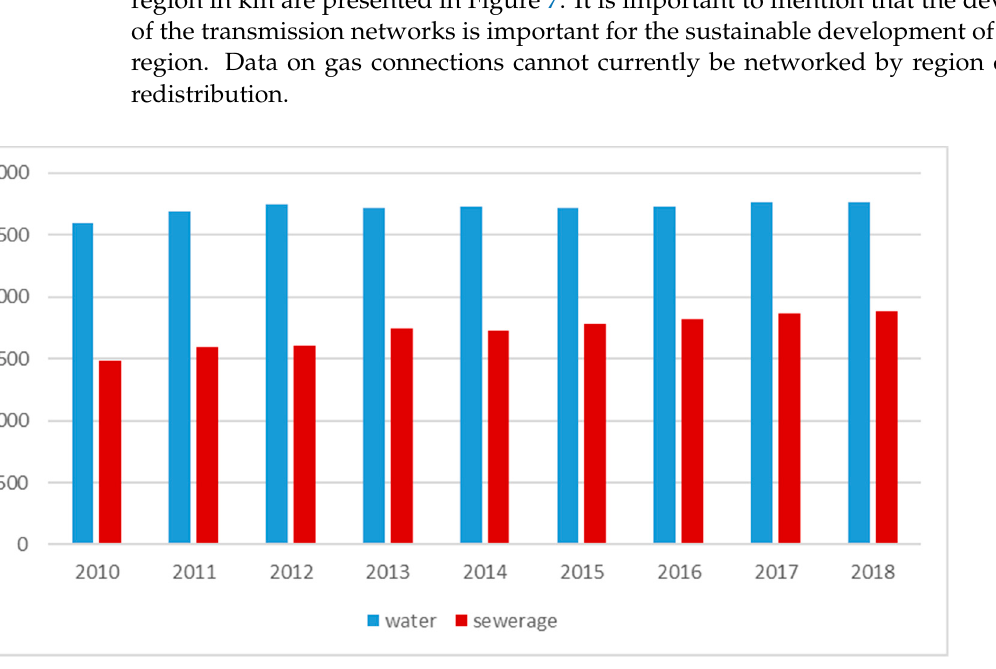
Figure 7. Length of transmission networks from 2010 to 2018 in rural regions of the Trnava region in km. Source: Own work based on data from Statistical Office of the Slovak Republic—Datacube [62].